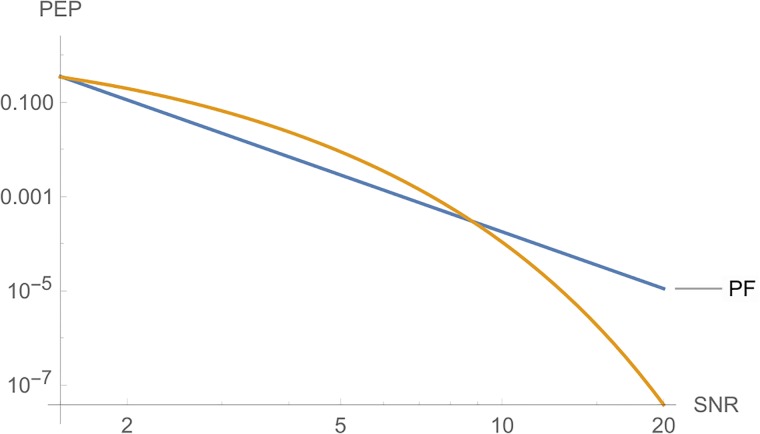
Graphs of PE and PF for Example 6, where nT = nR = l = 2, and SNR is a function of Es.